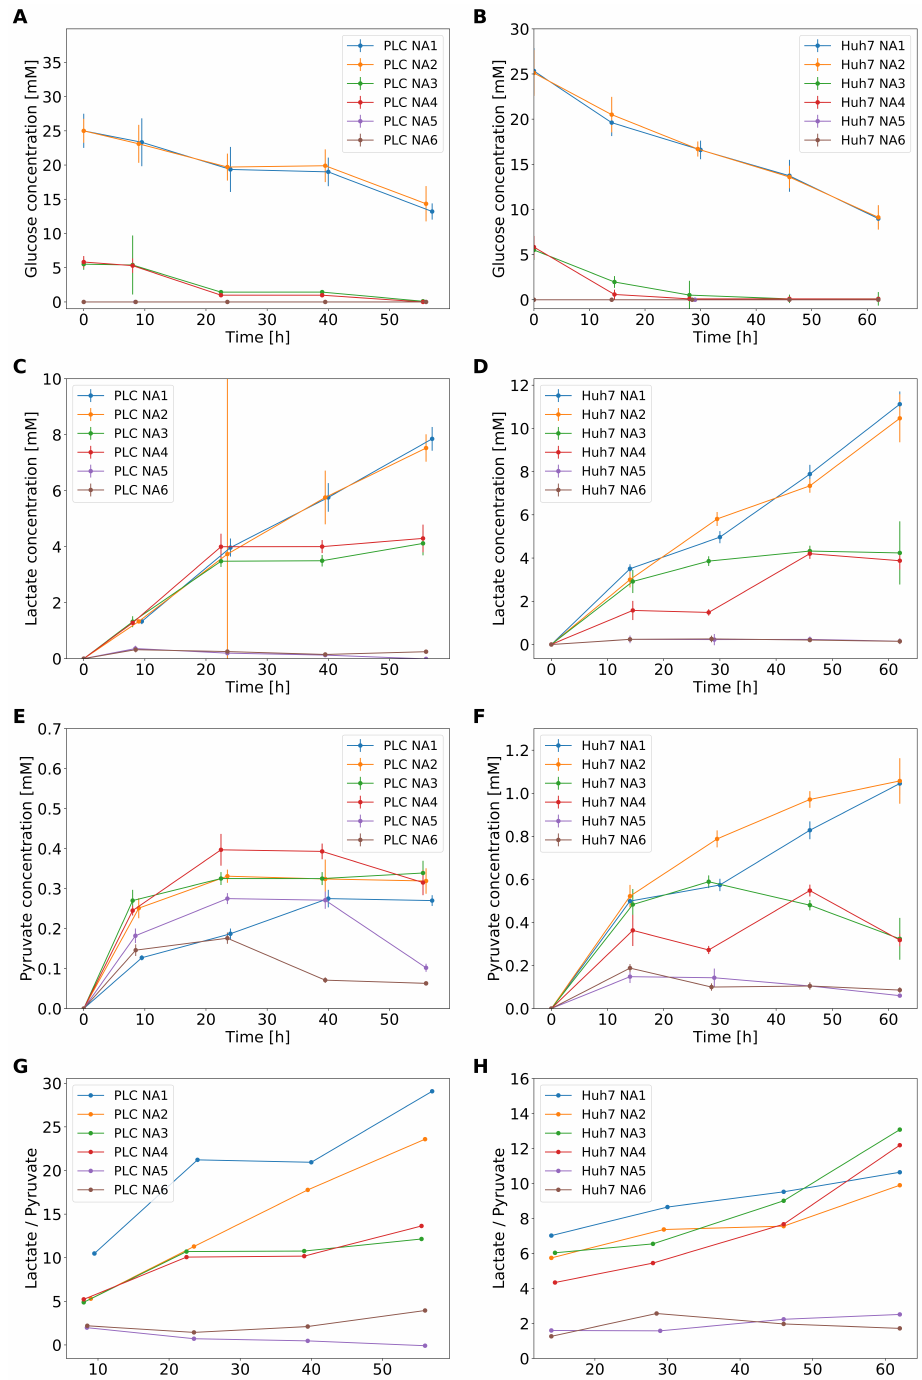
Figure 6. Metabolic performance as a function of time for Huh7 and PLC cells in six different media. Glucose consumption by PLC ( A ) and Huh7 ( B ) in four different media. In media M5 and M6 glucose was not detected. Lactate production by PLC ( C ) and Huh7 ( D ) cells. Pyruvate secretion by PLC ( E ) and Huh7 ( F ) cells. Ratio of extracellular lactate to pyruvate in PLC ( G ) and Huh7 ( H ) cells starting from the second time point measured in panels ( D – G ). In all six media the concentration of lactate and pyruvate before the experiments was 0